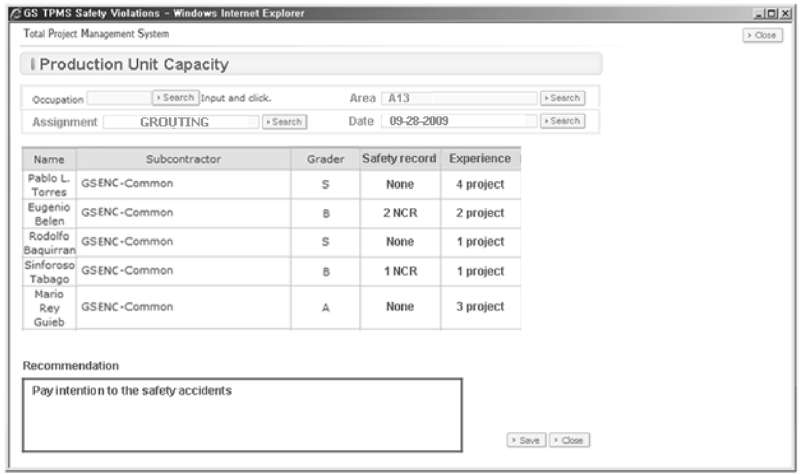
Fig. 12. Example of production unit capacity screen for production